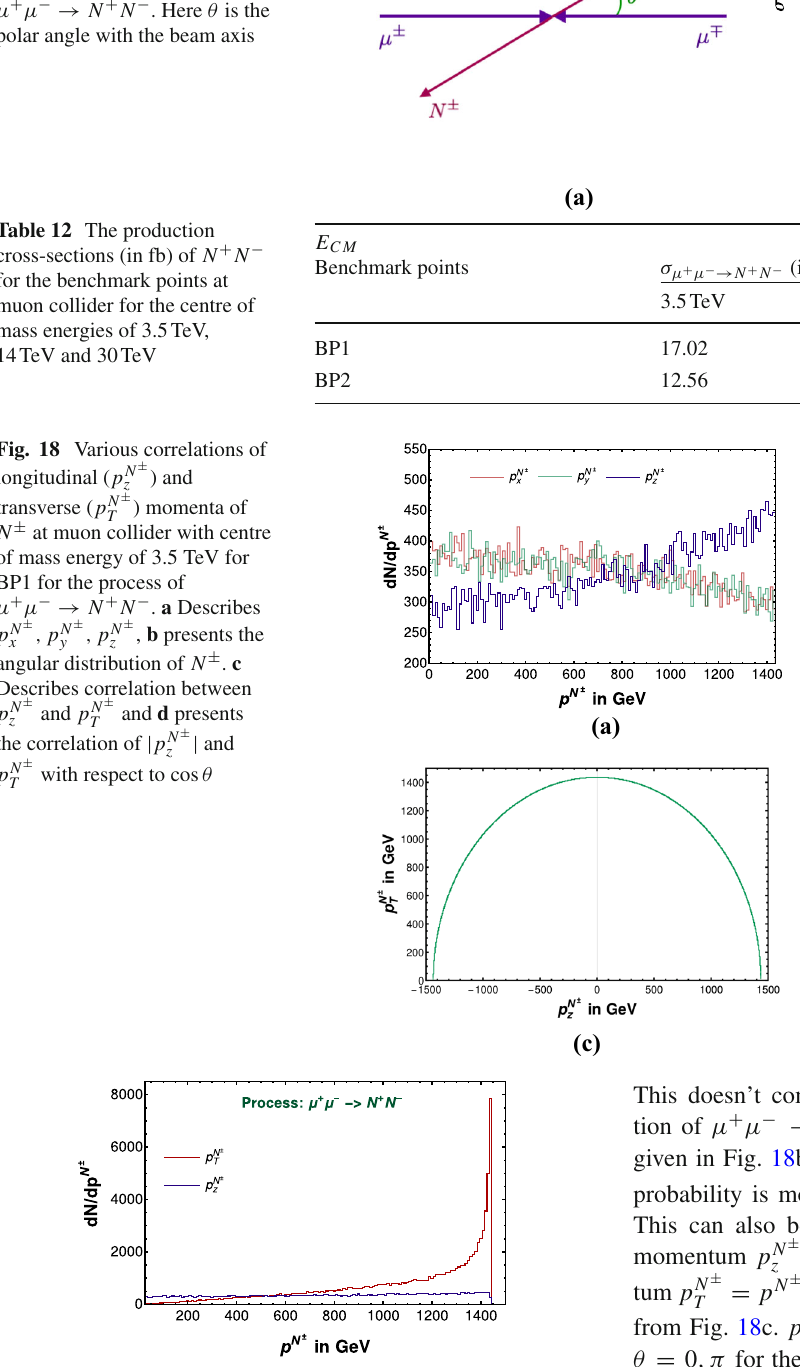
Fig. 17 a The Feynman diagram and b the cross-sections (in fb) as a function of centre of mass energy ( E CM ) for the benchmark points at muon collider for the process μ + μ − → N + N − . Here θ is the polar angle with the beam axis